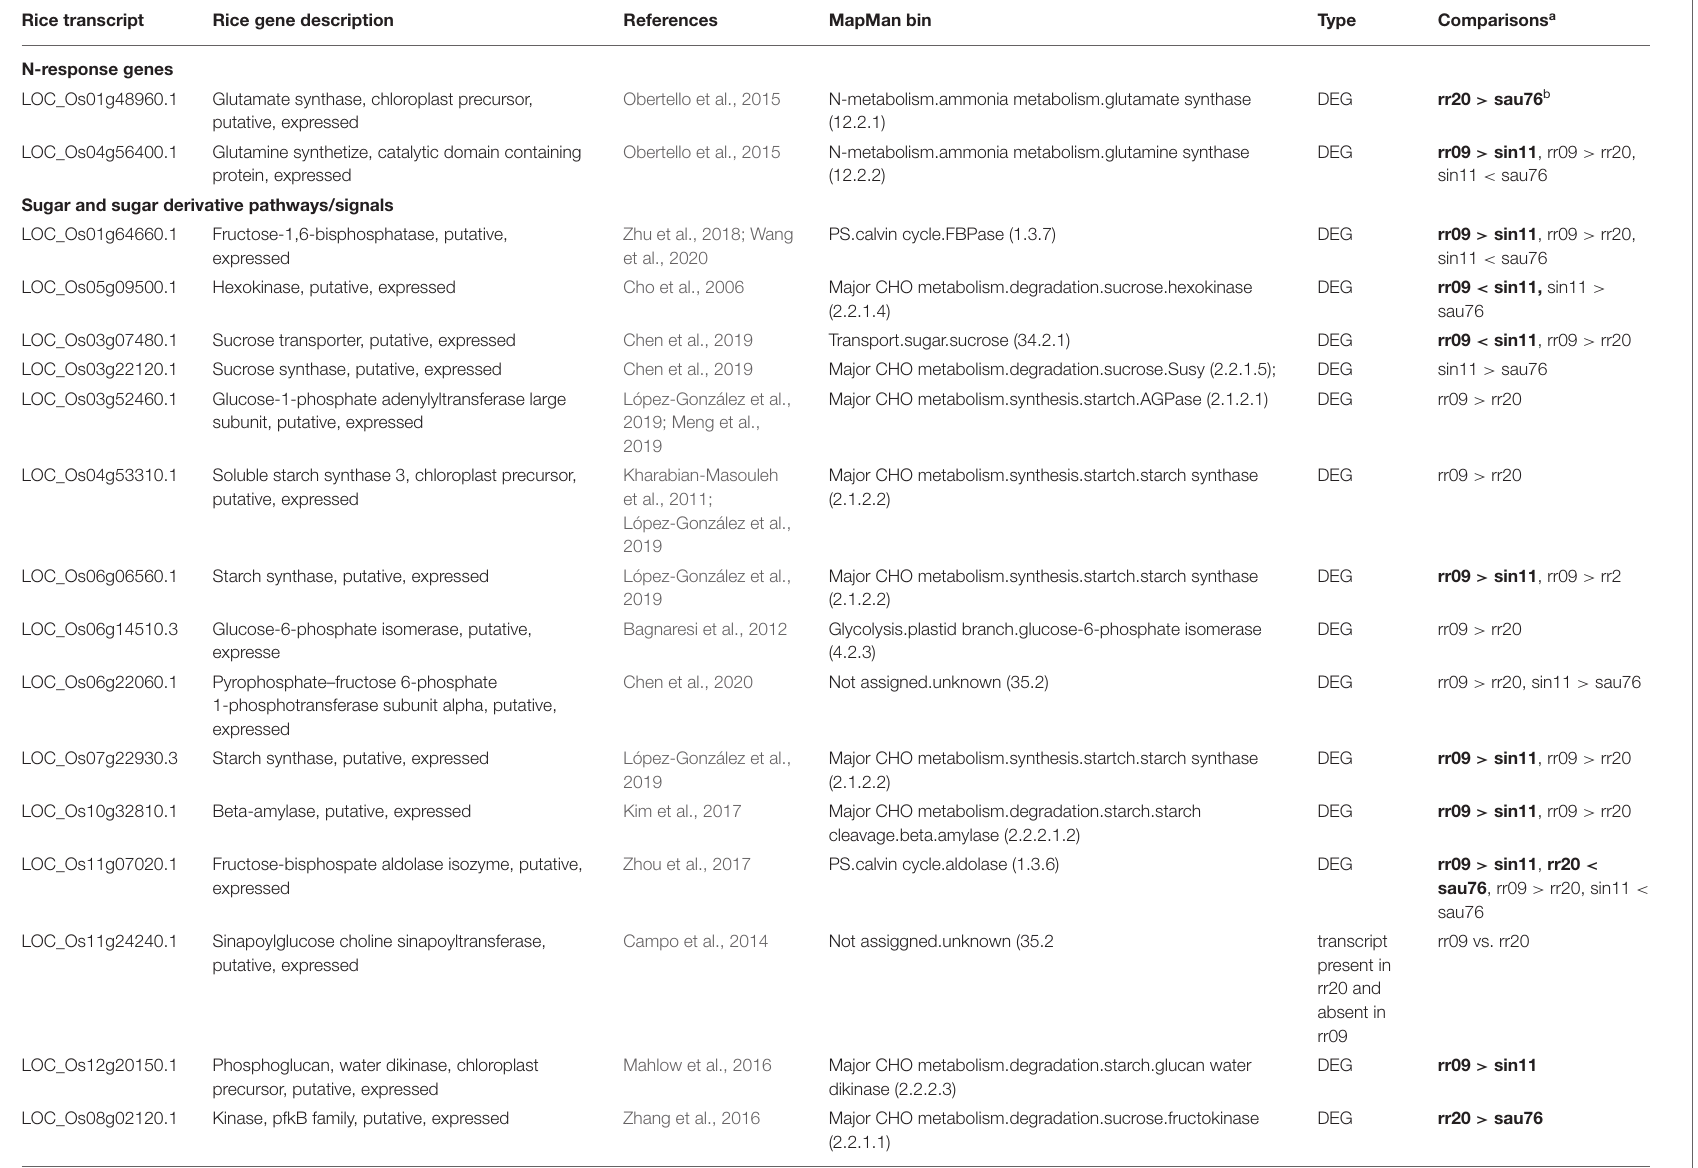
TABLE 4 | Oryza differentially expressed genes with potential associations with the observed phenotypic